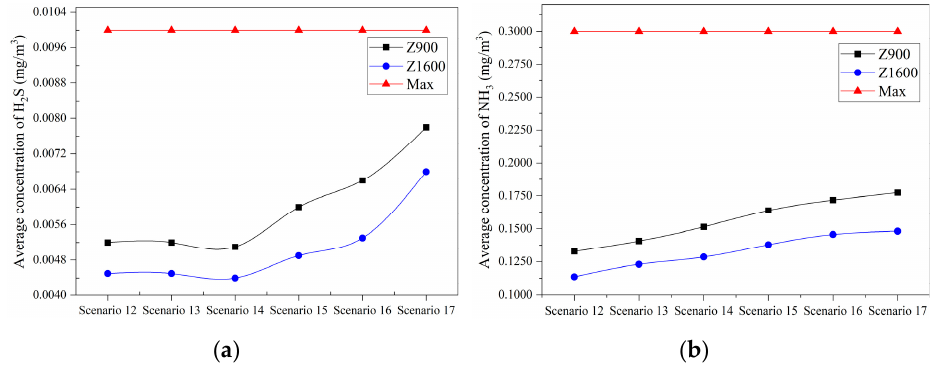
Figure 11. Variation trend in the ACIPs for different exhaust vent heights. ( a ) Average concentration of H 2 S; ( b ) Average concentration of NH 3